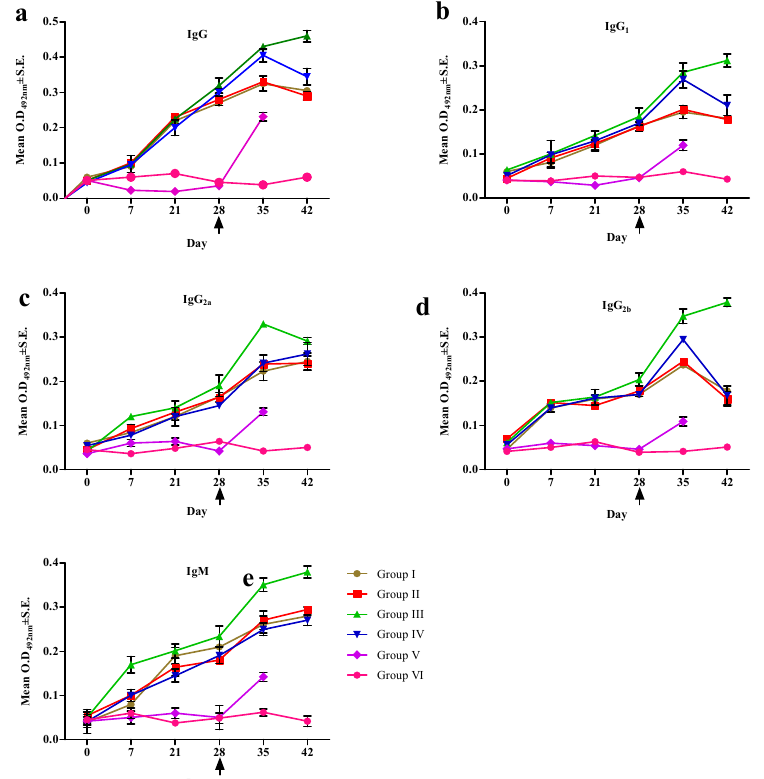
Figure 2. The serum profile of IgG ( a ), IgG 1 ( b ), IgG 2a ( c ), IgG 2b ( d ), and IgM ( e ) in mice following immunization with recombinant TePFR proteins and challenge with live T. evansi (arrow). rTePFR1, rTePFR2 and an equimolar mixture of rTePFR1 and rTePFR2 were used as detection antigen for the indirect ELISA to assess the specific antibody responses in the respective treatment groups (Group I, Group II, and Group III, respectively). We compared the humoral response induced by rTePFR with that of the native T. evansi whole-cell lysate antigen (TeWCL) immunized group and used the native TeWCL antigen in ELISA for Group IV. Data presented as Mean ± SEM from the surviving mice in each group. Note, day 42 (equivalent to 14 days post-challenge) is the last data point presented, after which mortality begun to undermine representative group sizes. The arrow denotes the day of challenge.